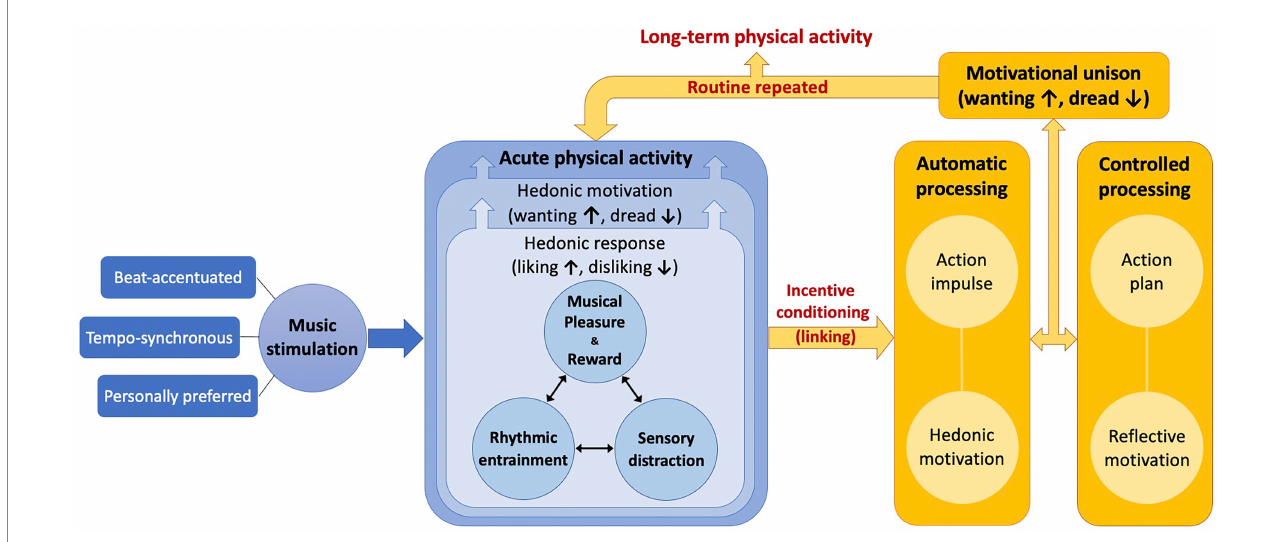
FIGURE 1 A theoretical model named “Music as an Affective Stimulant for Physical Activity” (MASPA). Acute phase of physical activity is depicted in blue whereas long- term phase of physical activity is illustrated in yellow. Regularly repeating acute routine can lead to long-term physical